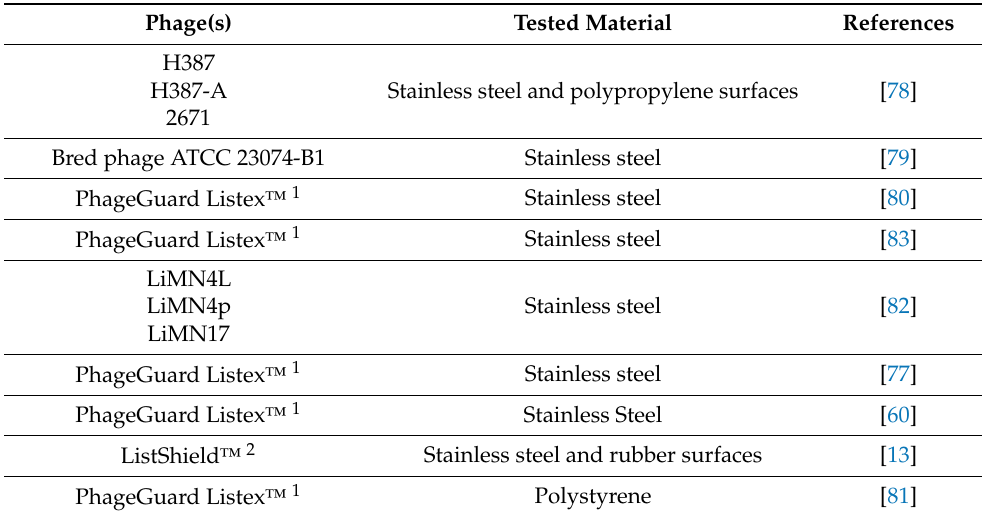
Table 3. Summarized attempts of phage-based Listeria monocytogenes inhibition on di ff erent